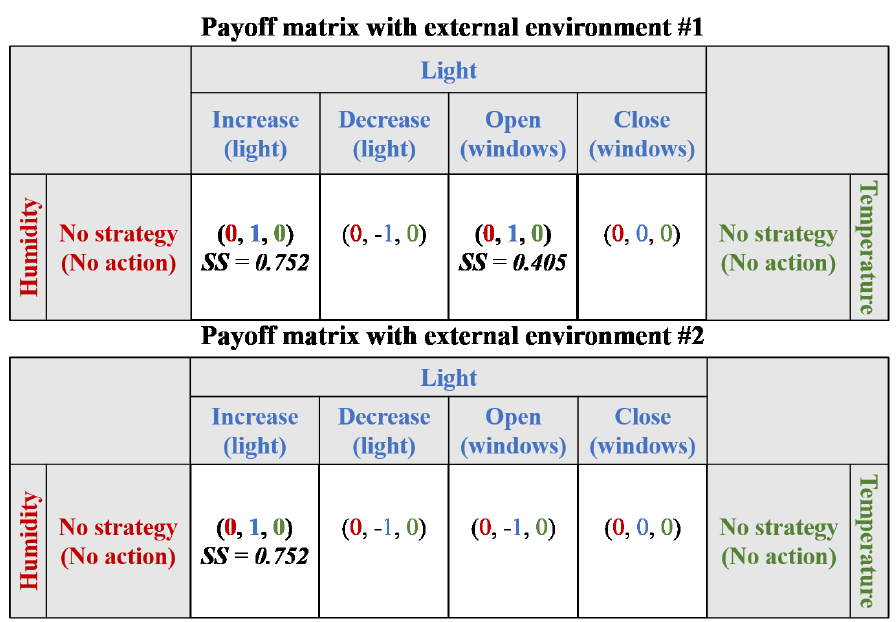
Figure 8. Payoff matrix for Scenario #1 ( α = 0.5 and β =